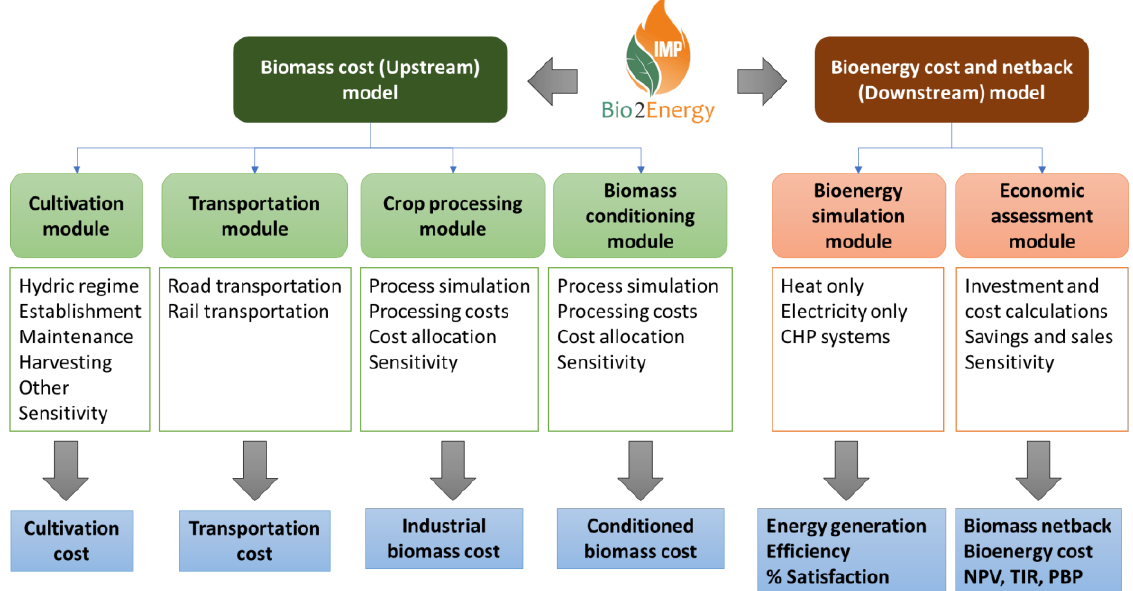
Figure 1. Overview of the models in IMP Bio2Energy® used for techno-economic assessment of biomass and bioenergy costs.